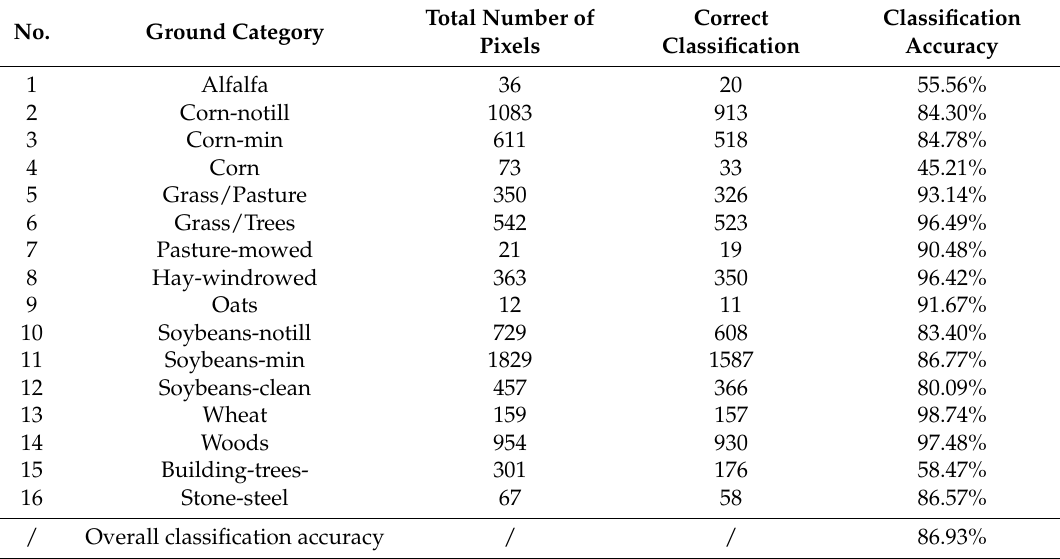
Table 8. Statistics of traditional CNN classification chart accuracy used Indian Pines